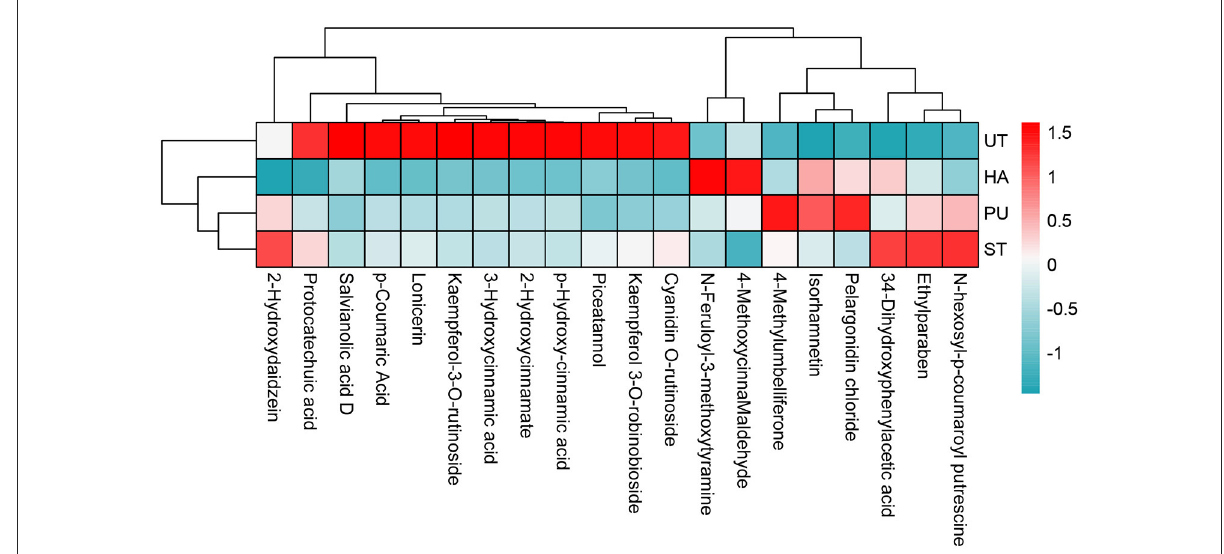
FIGURE9 Heatmap of FP with VIP > 1 in camellia oil.